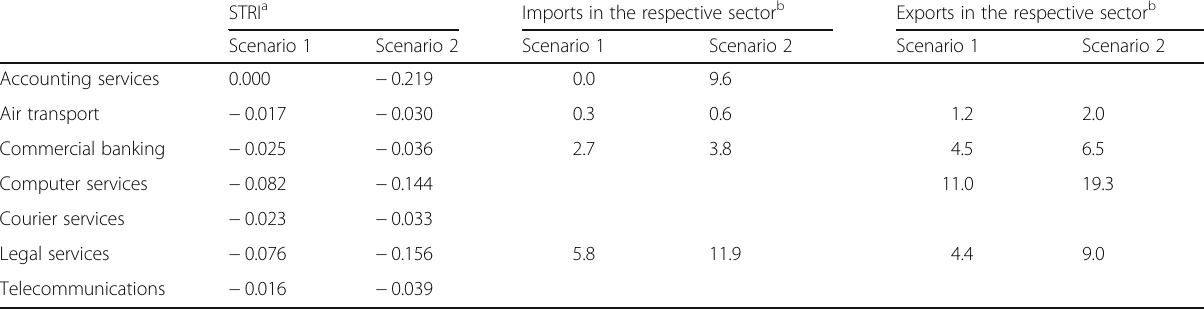
Table 4 Impact of services trade liberalization on trade flows in